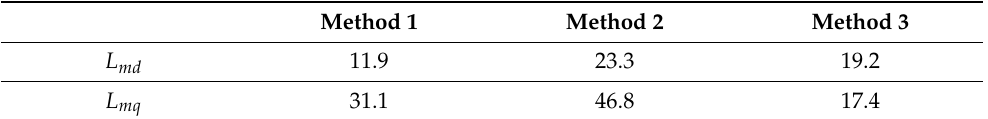
Table 2. Calculated L2 norms for the deviations between the experimentally and analytically obtained